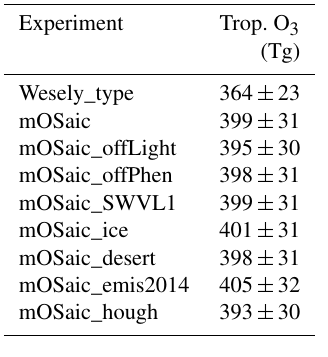
Table 4. Annual mean tropospheric ozone burden for all experi- ments and 1 σ standard deviation.